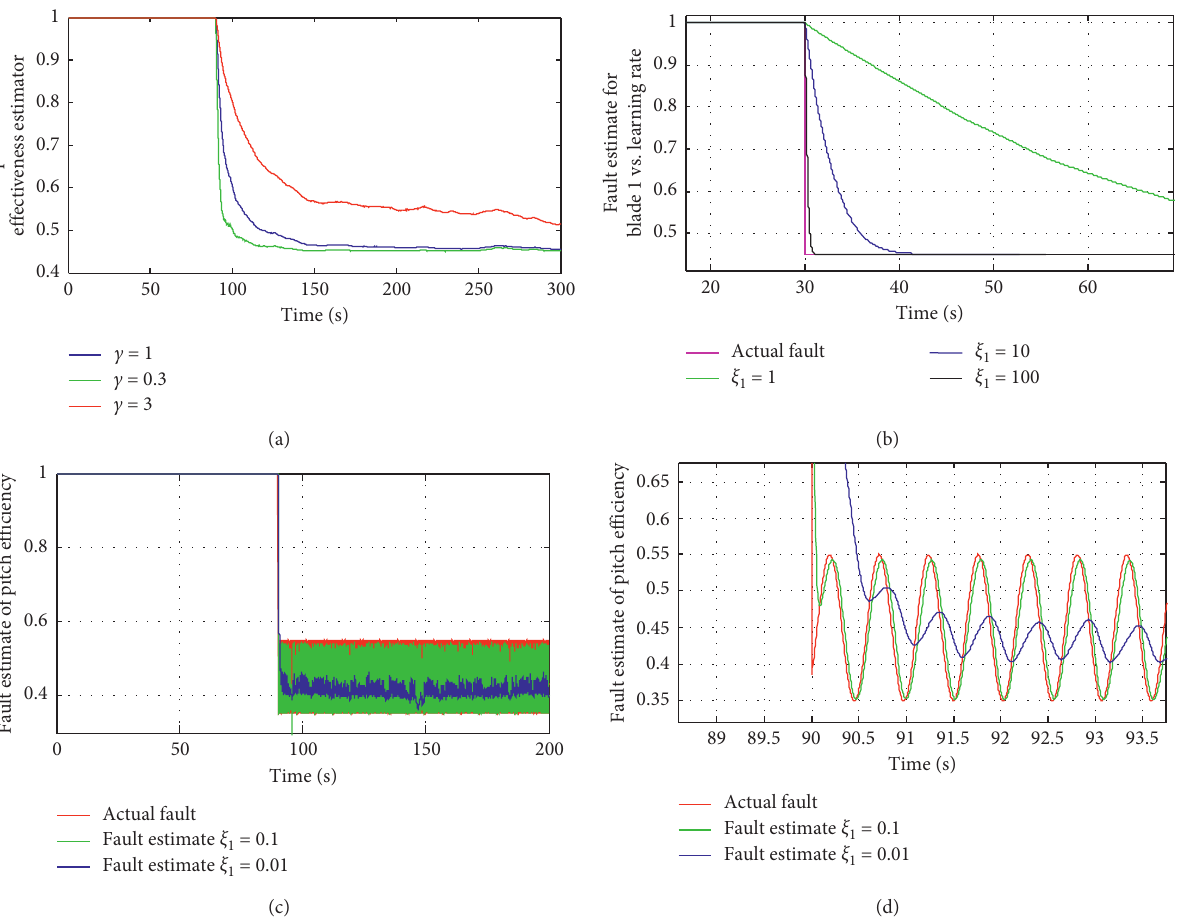
Figure 6: (a) Estimation of the pitch 1 actuator effectiveness for different performance levels. (b) Estimation of the pitch 1 actuator effectiveness for different learning rates. (c) Fault estimate with dynamics faster than system dynamics. (d) Zoom on fault estimate with dynamics faster than system dynamics.